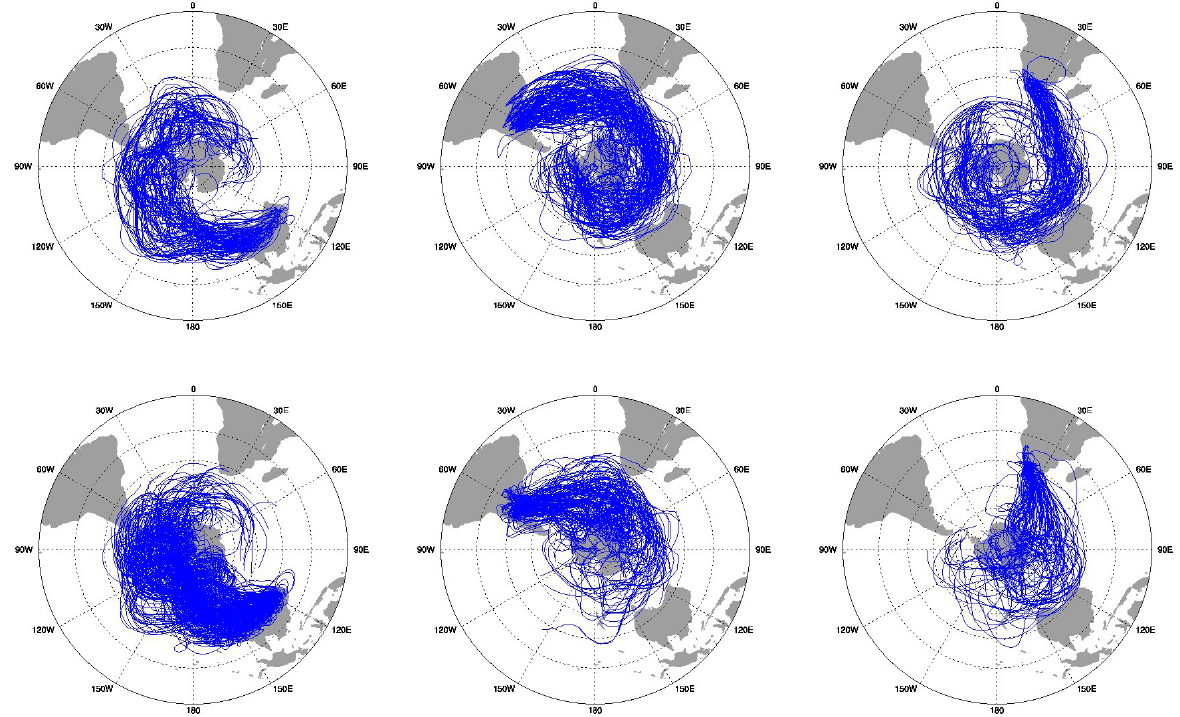
Figure 9. Ten-day forward trajectories of air masses originating at 500 (top) and 800hPa (bottom). Trajectories originated over the Australian (left), South American (central) and southern African (right) dust sources and reached Antarctica within 10 days. Trajectories are shown for the CTRL simulation in the austral spring season (SON). Note that only every second trajectory is